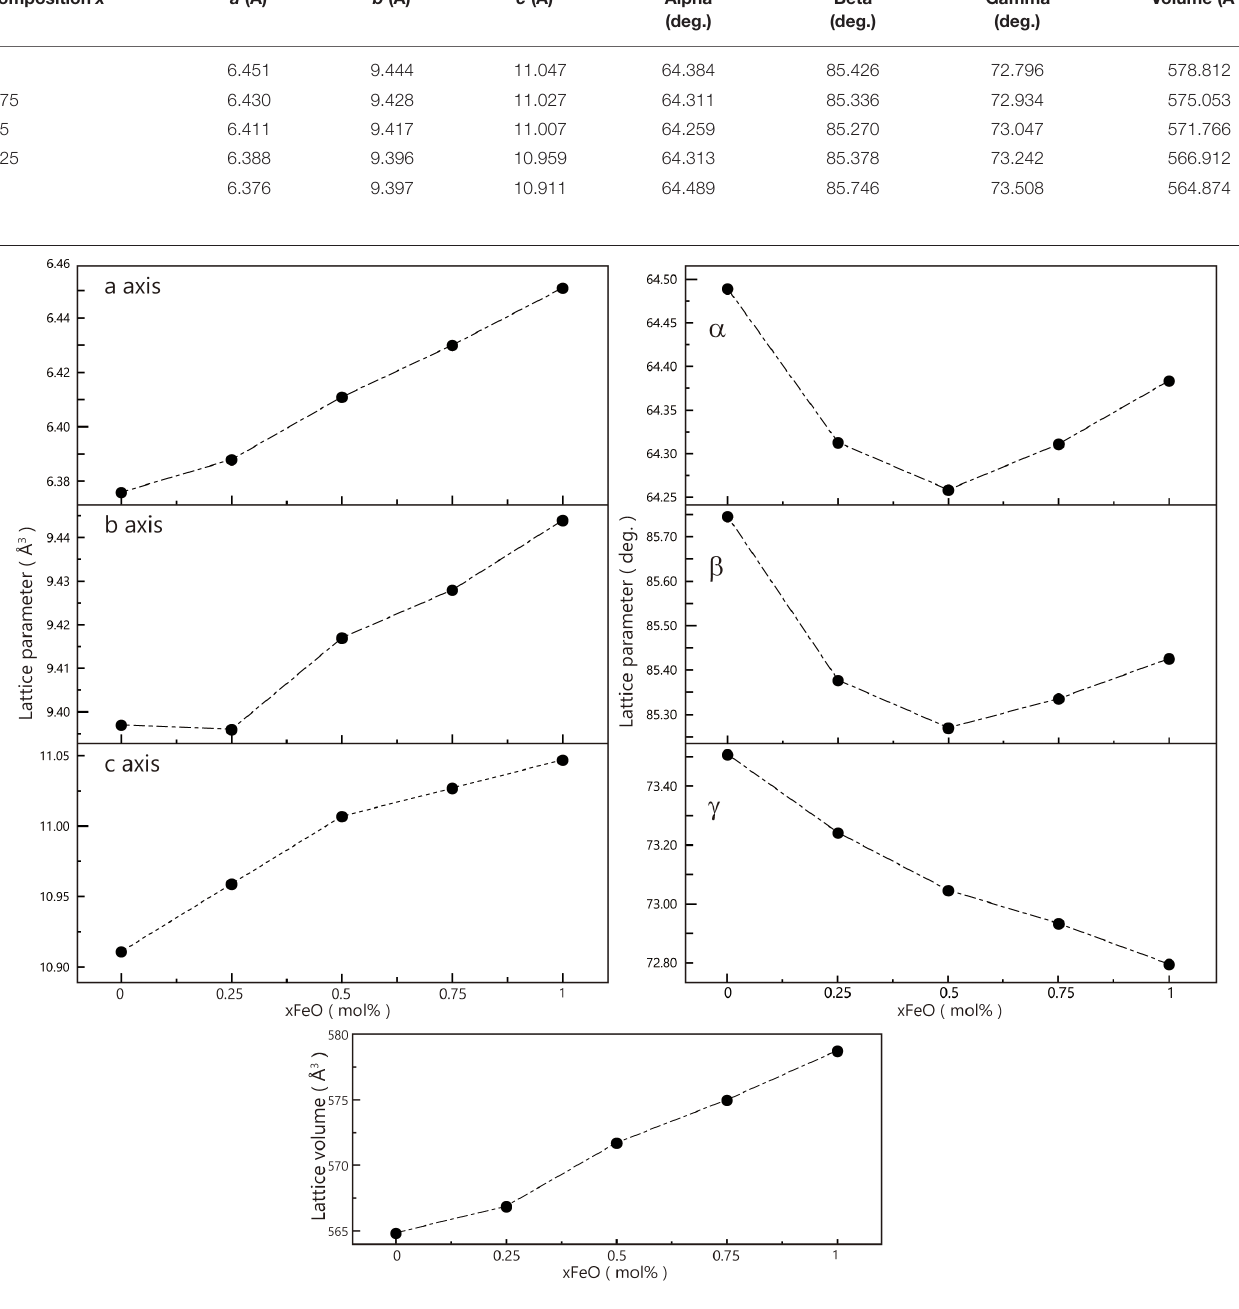
FIGURE 8 | Lattice parameters of crystallized Na 2 Fe x Ni 1 − x P 2 O 7